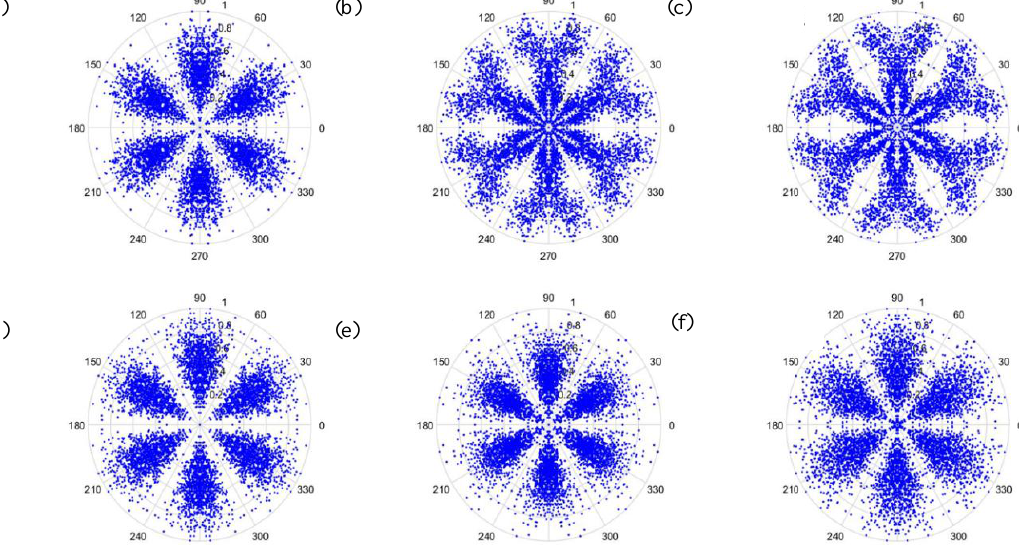
Figure 14. Results from improved formula when t = 0 and sampling is at 3000 Hz / 2000 rpm. ( a ) Normal, ( b ) motor platform with one eccentric screw, ( c ) motor platform with two eccentric screws, ( d ) sanded ball bearings, ( e ) insufficient lubrication, and ( f ) worn ball bearings.